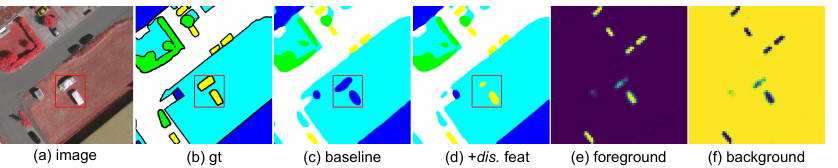
Figure 5. The effect of dis . feat. ( a ) Image; ( b ) ground truth; ( c ) baseline prediction; ( d ) prediction with dis . feat; ( e )/( f ) the foreground/background feature of the group of target category. Obviously, our dis . feat can correct misclassification, highlighted in the red box